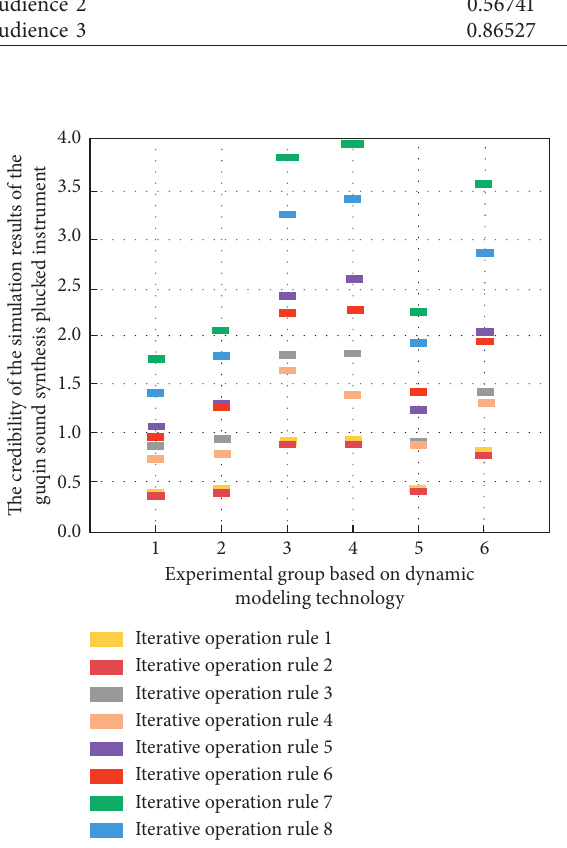
Figure 8: Quantitative analysis results of the credibility of the guqin piano sound synthesis plucked string instrument